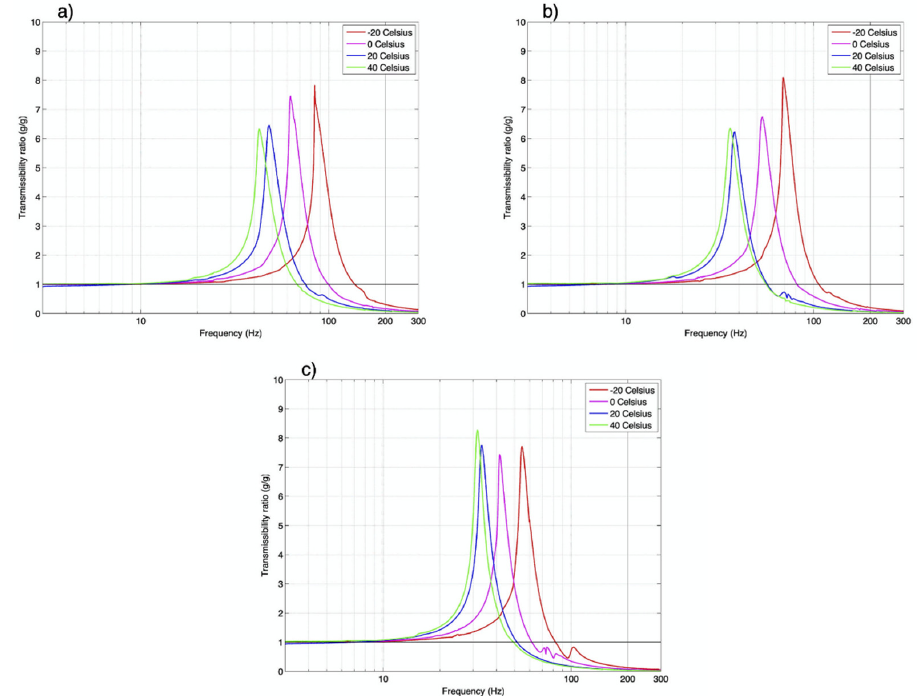
Figure 8. Vibration transmissibility and frequency curves for ( a ) PE30 at a static load of 3.488 kPa, ( b ) PE30 at a static load of 4.651 kPa, and ( c ) PE30 at a static load of 6.976 kPa (frequency is in logarithmic scale).